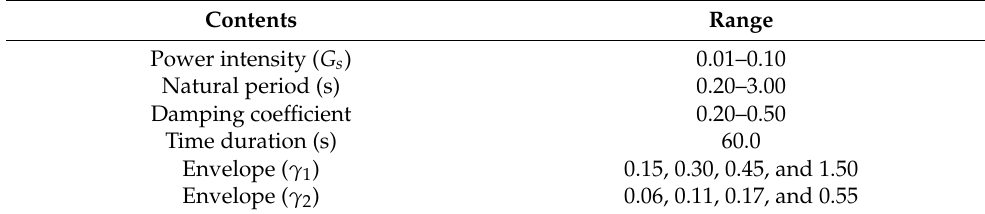
Table 6. Parameter range for input ground motion.